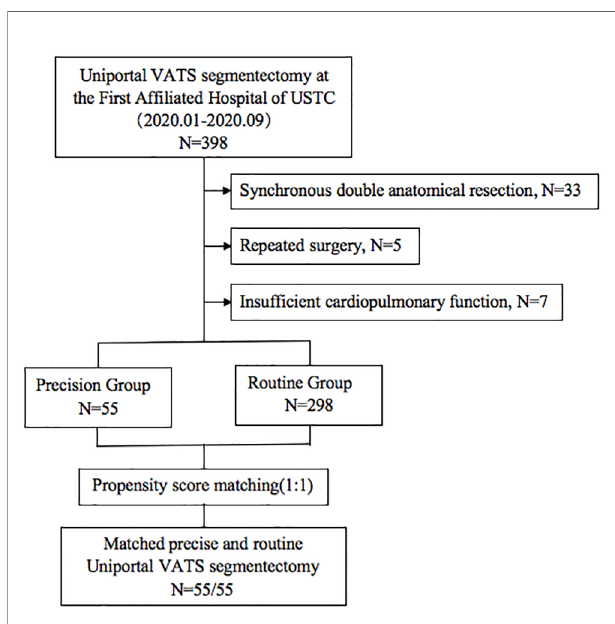
FIGURE 1 | The fl ow chart of patient